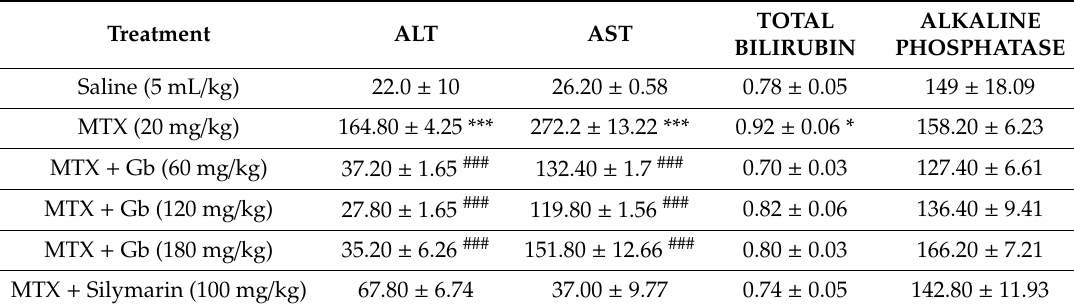
Table 1. E ff ect of Gb on liver biochemical